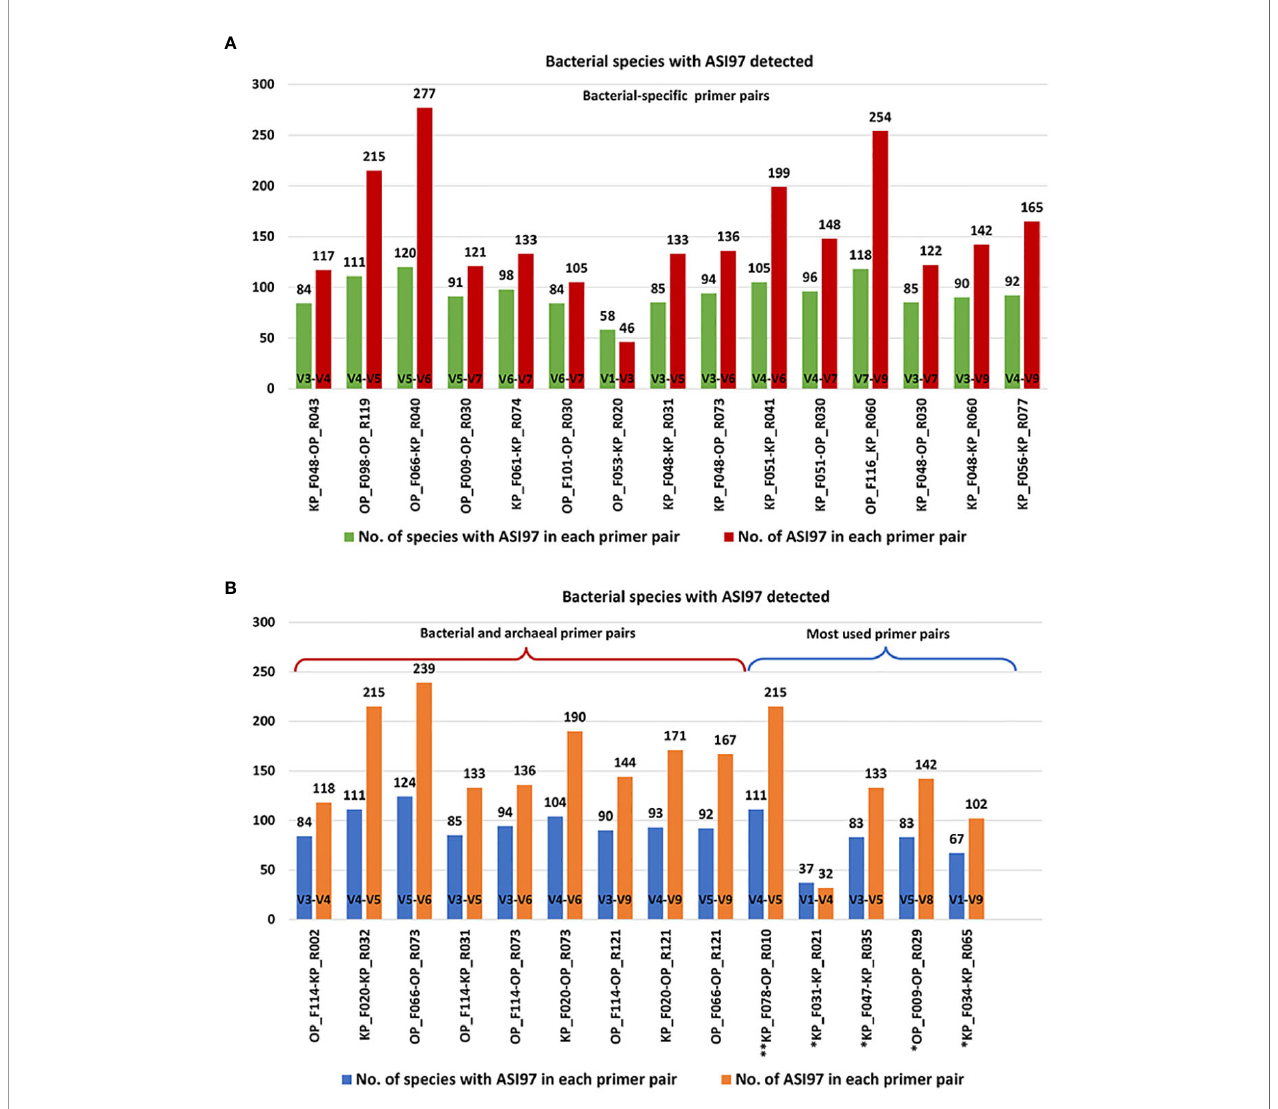
FIGURE 2 | Number of bacterial species with in-silico amplicon similarity values ≥ 97% and number of in-silico amplicon similarity values ≥ 97% with the primer pairs evaluated against the oral bacteria genomes. (A) Estimates were obtained by the selected bacterial-speci fi c primer pairs. (B) Estimates were obtained by the selected bacterial and archaeal primer pairs and the primer pairs used the most in the oral microbiome literature. Among the most commonly used primer pairs in the literature, those marked with an * are bacterial-speci fi c and those with ** target both bacterial and archaea. ASI97, in-silico amplicon similarity values ≥ 97%; F, forward; KP, Klindworth primer; No., number; OP, oral primer; R,